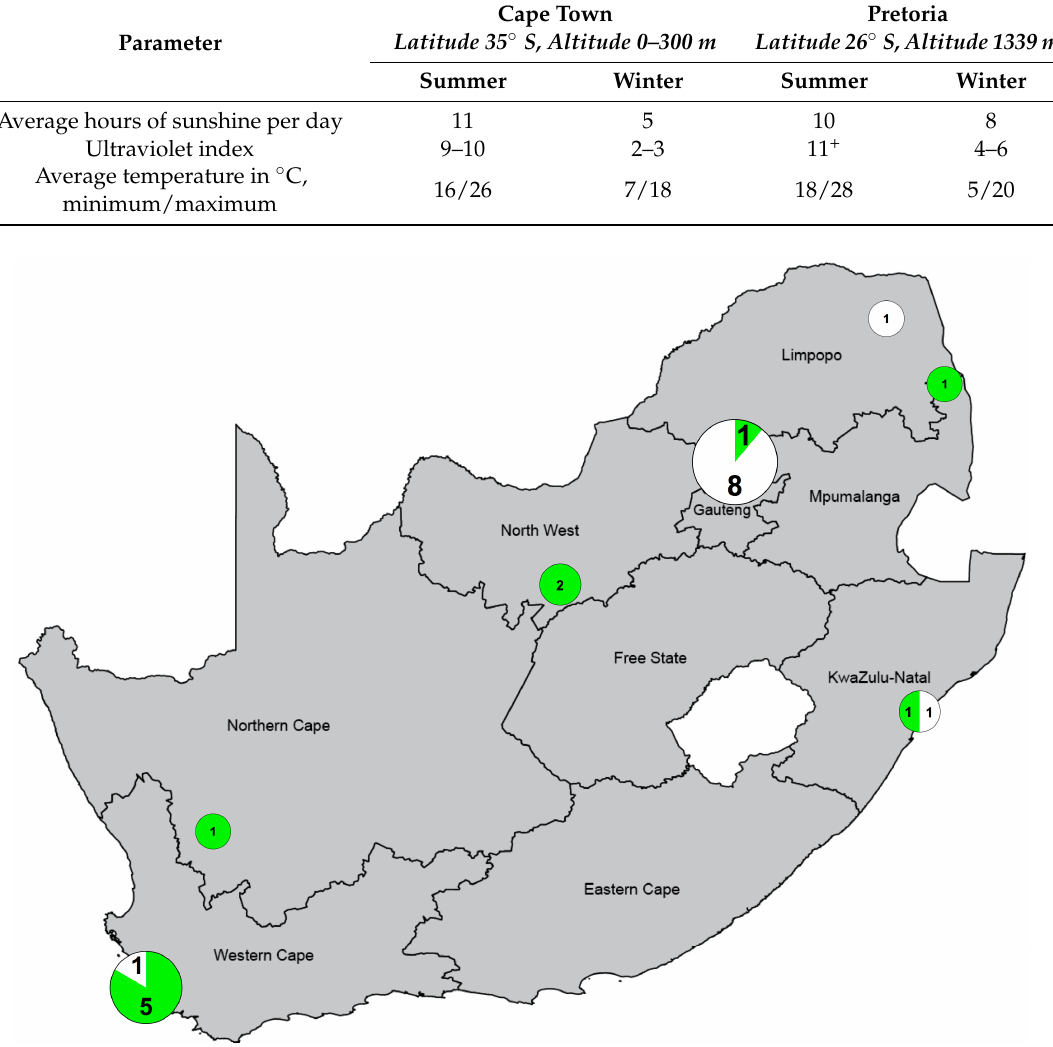
Figure 1. The number of publications investigating the association between vitamin D status and disease in the Provinces of South Africa. Green indicates a significant association, and white indicates no significant association. The size of the Venn diagrams is proportional to the number of studies. Map adapted from Global Security [19] and the Venn diagrams were plotted using GraphPad PRISM 6.